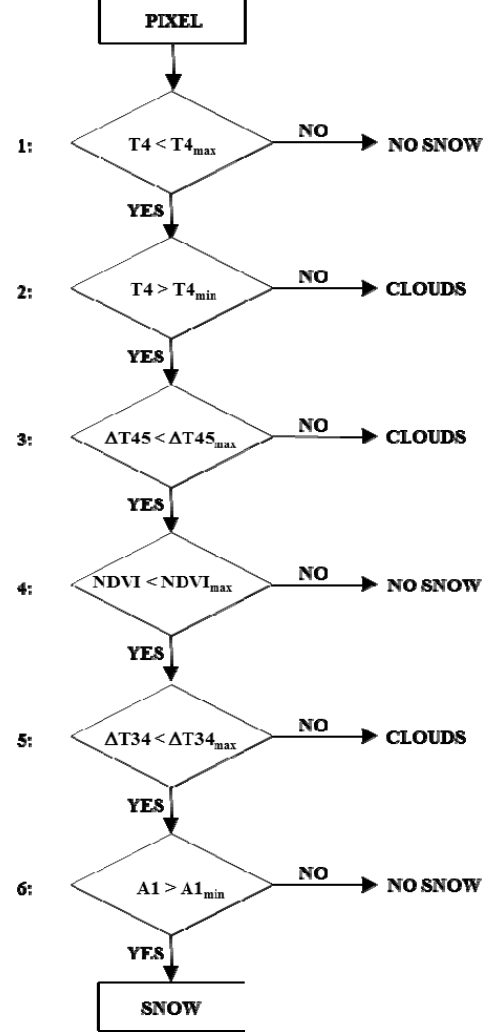
Figure 2. Flow chart of the AVHRR algorithm (reprinted from [13]). NDVI, Normalized Difference Vegetation